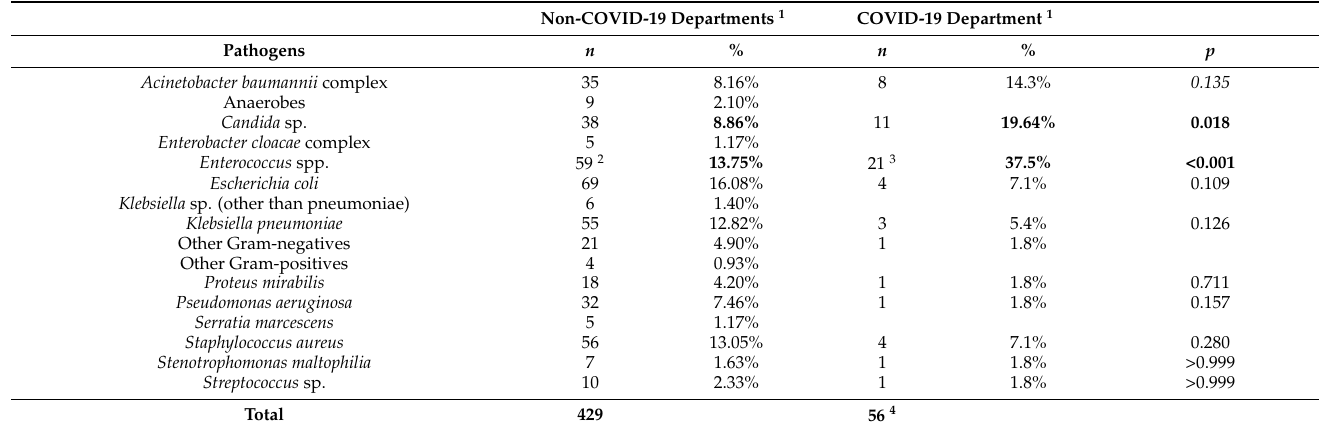
Table 1. Blood isolates in COVID-19 and non-COVID-19 departments. Bold means statistical signifi- cant values.